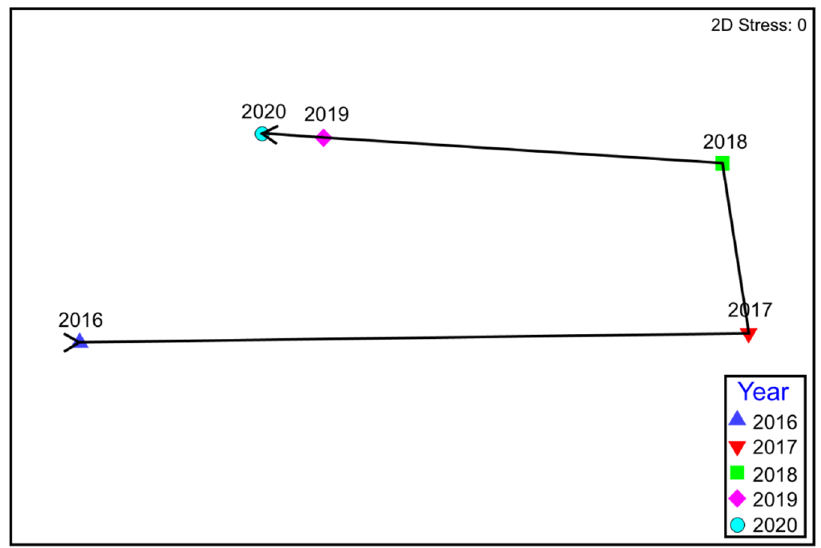
Figure 15. Average percent cover of all herbaceous species demonstrating the overall looped pattern from 2016 to 2020.